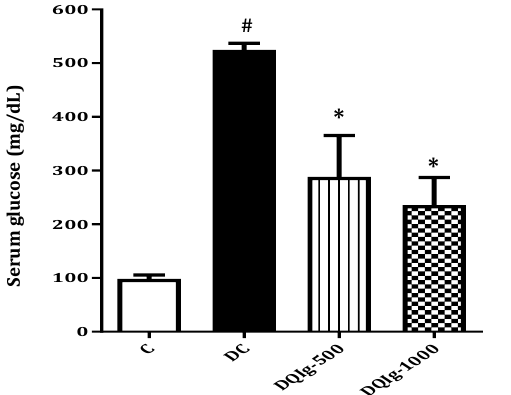
Figure 2. Effects of Quercus infectoria galls (QIg) extract on serum glucose concentration in diabetic male Wistar rats. Data are shown as mean±SEM, n=4. C, negative control; DC, diabetic control; DQIg-500, diabetic rats treated with 500 mg/kg BW/day of QIg extract; DQIg-1000, diabetic rats treated with 1000 mg/kg BW/day of QIg extract. # P <0.05 compared to NC, * P ≤ 0.05 compared to DC